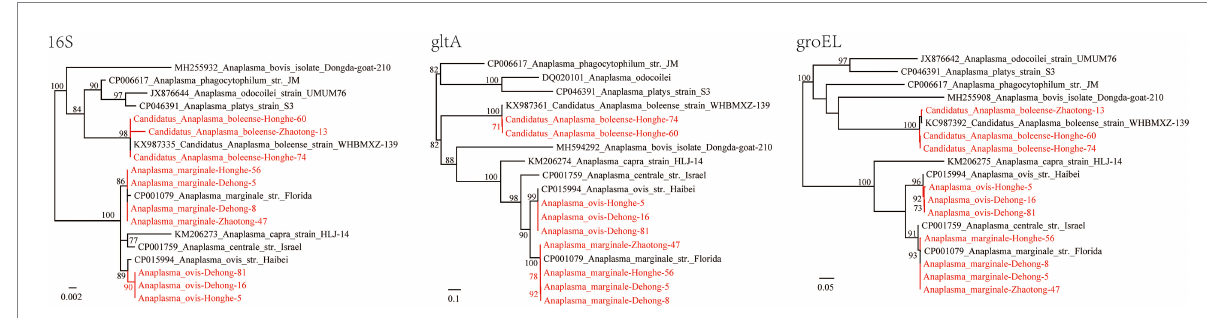
FIGURE 3 Phylogenetic trees constructed by the PhyML 3.0 software based on the nucleotide sequences of 16S rRNA (854–1,206 bp), gltA (539 bp), and groEL (846 bp) genes of Anaplasma strains. The bootstrap values were shown on the nodes. Red: the strains identified in this study.